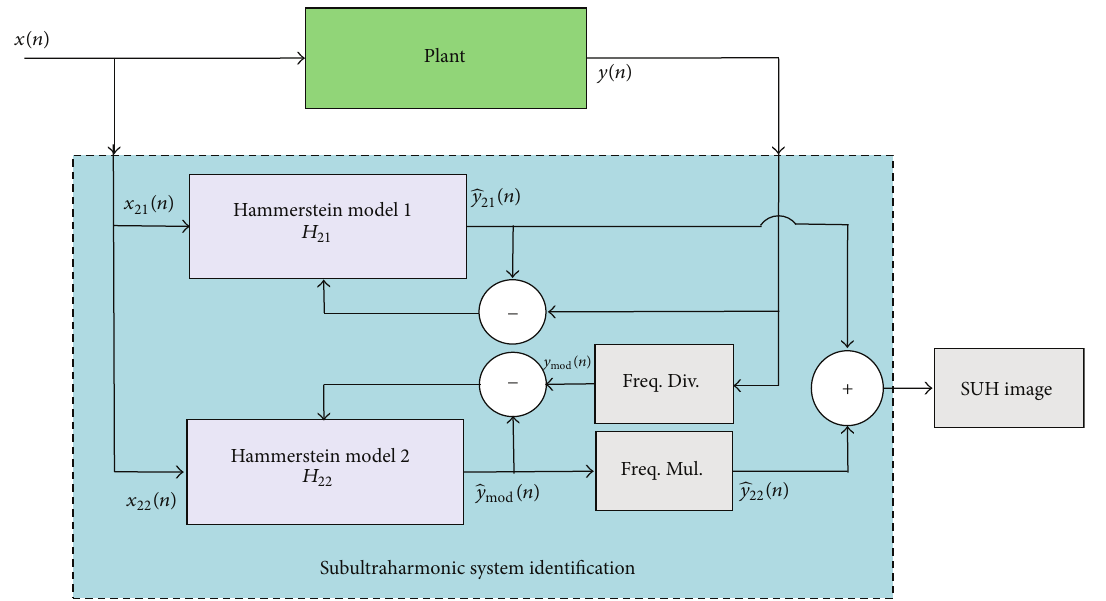
Figure 5: Block diagram of method 2: modeling by output frequency shifting.